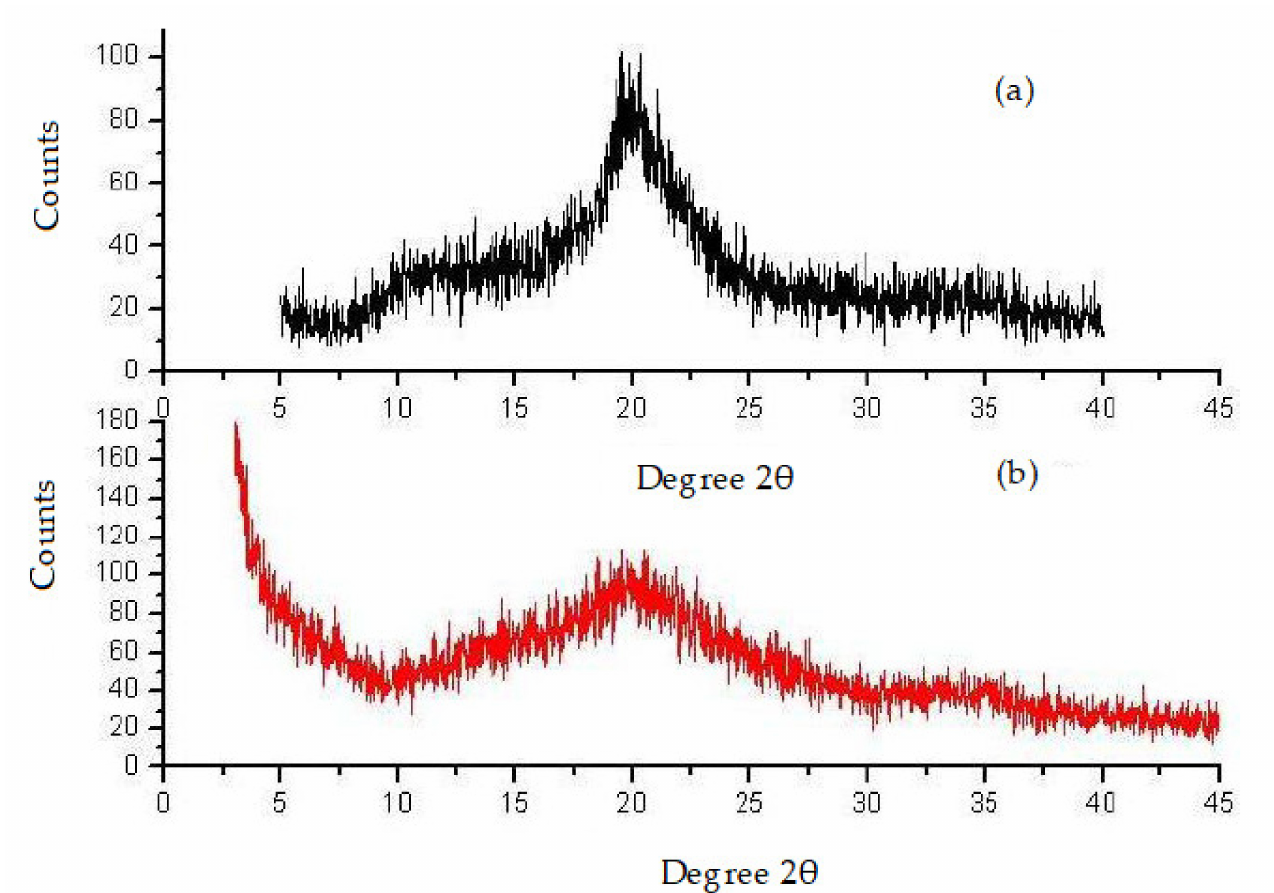
Figure 5. X-ray Diffraction Study of pure chitosan ( a ) and chitosan derivative ( b ).